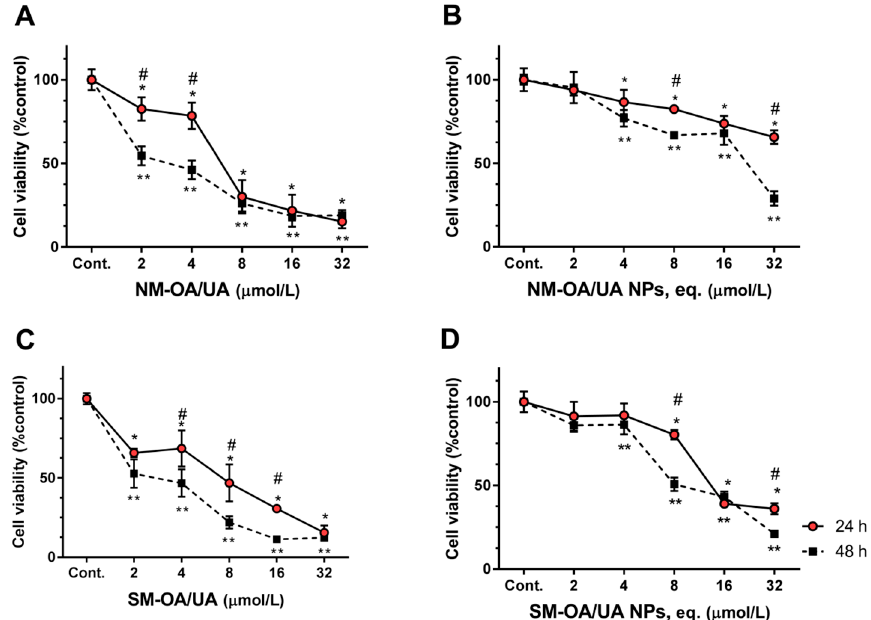
Figure 4. The effect of OA/UA on Y-79, human retinoblastoma cells viability. Y-79 cells were exposed Figure 4. The e ff ect of OA / UA on Y-79, human retinoblastoma cells viability. Y-79 cells were exposed to NM-OA/UA ( A ), NM-OA/UA NPs ( B ), SM-OA/UA ( C ), SM-OA/UA NPs ( D ), for 24 and 48 h, as to NM-OA / UA ( A ), NM-OA / UA NPs ( B ), SM-OA / UA ( C ), SM-OA / UA NPs ( D ), for 24 and 48 h, denoted. Statistically significant differences, p < 0.05 are denoted with * or **, in relation to respective as denoted. Statistically significant di ff erences, p < 0.05 are denoted with * or **, in relation to respective control at 24 or 48 h, respectively; # denotes statistical differences for incubation periods at indicated control at 24 or 48 h, respectively; # denotes statistical di ff erences for incubation periods at indicated concentration. The results are the mean ± S.D. of n = concentration. The results are the mean ± S.D. of n = 4.